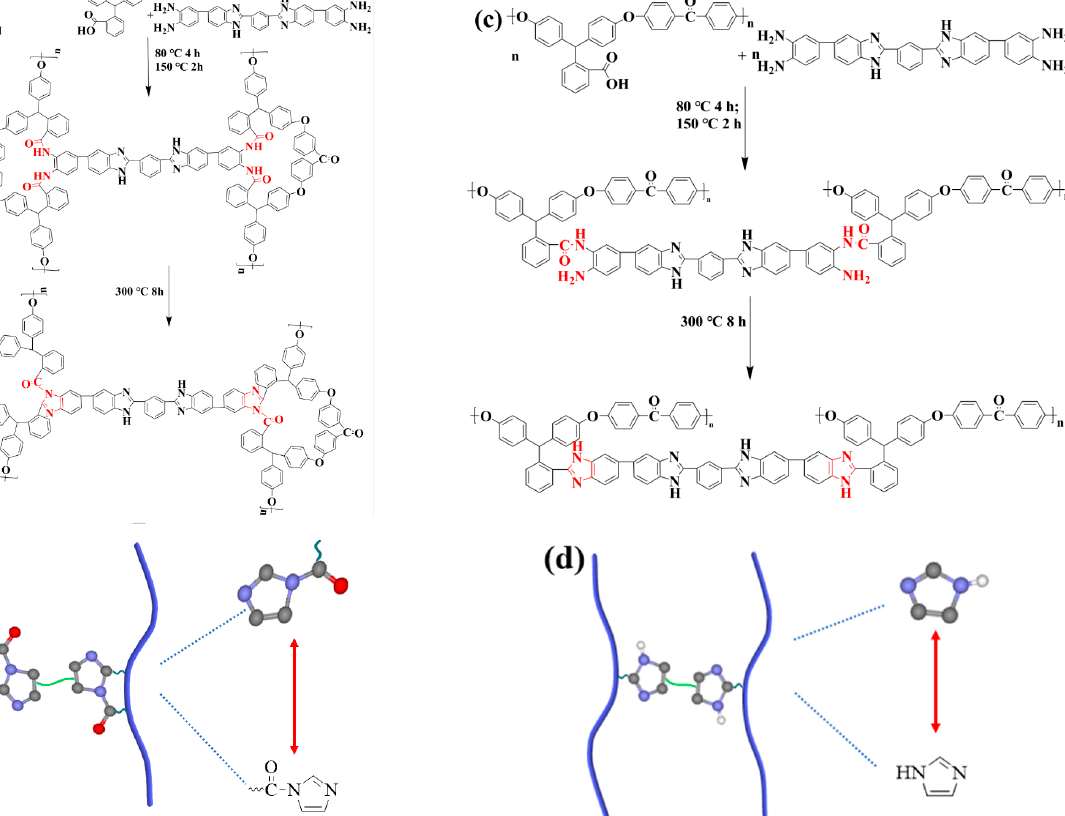
Scheme 3. Cross-linking mechanism and corresponding structure diagram of PAEK- cr -PBI membrane to form acyl benzimidazole ( a , b ) and benzimidazole ( c , d ).